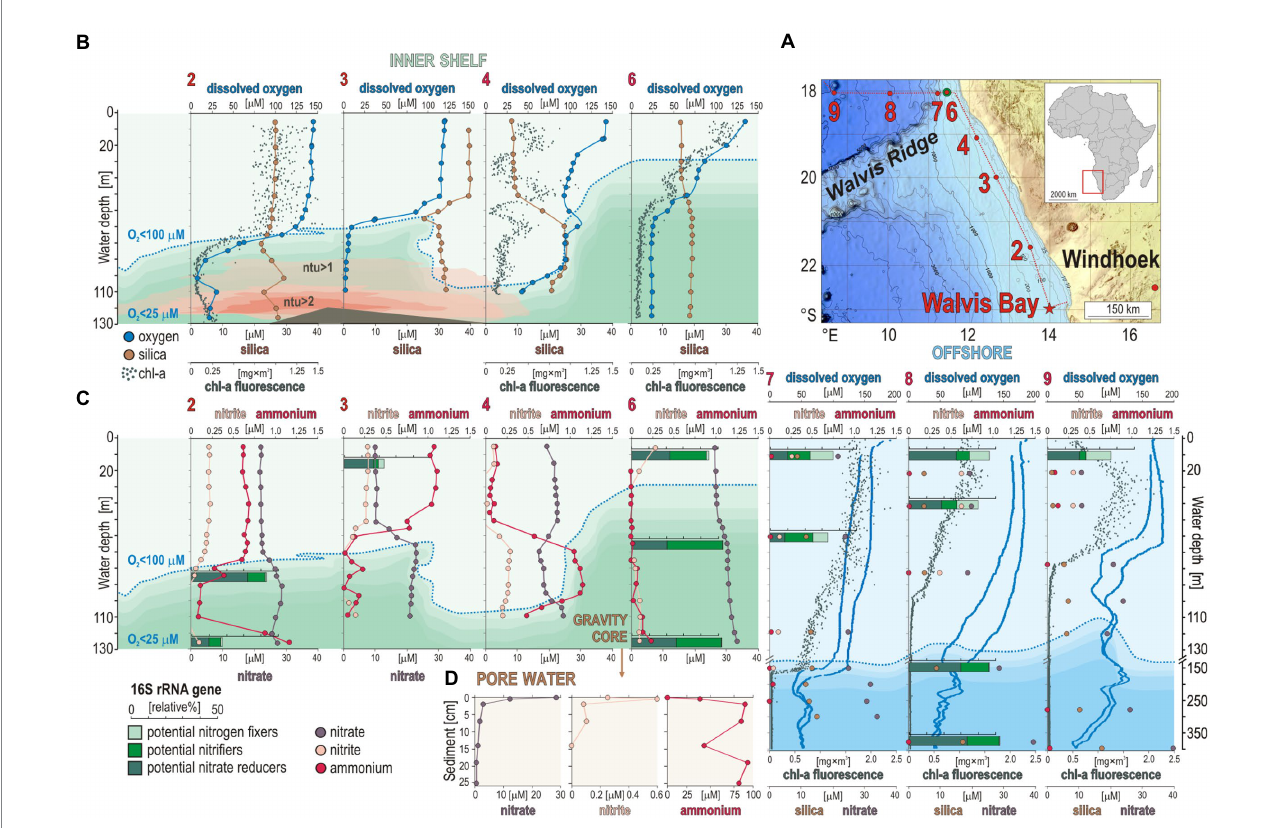
FIGURE 1 Sampling sites along the Namibian shelf, water column geochemical profiles, with a relative abundance of microbial guilds involved in nitrogen cycling, and pore water geochemistry. (A) Bathymetric map of the Namibian shelf (data from Weatherall et al., 2021) displaying the different sites sampled during the EreBUS cruise 2018. (B) Concentration profiles for dissolved oxygen (blue) with an oxycline defined as <100 μ M (dotted line), silica (brown), chlorophyll- a (green), and turbidity in nephelometric turbidity units (ntu) at each successive sampling site. (C) Concentration profiles for nitrite (pink), ammonia (red), and nitrate (purple) in the water column at each successive site, with relative abundances (% bar charts) of potential nitrogen fixers (light green), potential nitrifiers (green), and potential nitrate reducers (dark green). (D) Pore water geochemical profiles for nitrate (purple), nitrite (pink), and ammonium (red). Geochemical data are adapted from Siccha and Kucera (2018), Garaba et al. (2021), and Ferdelman et al.